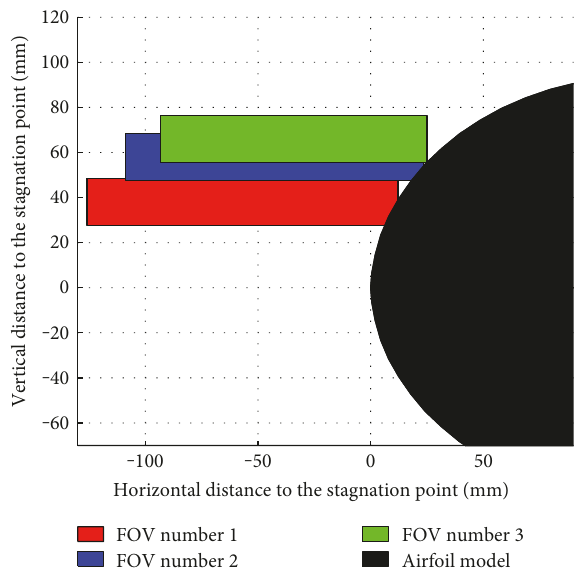
Figure 6: Location of the di ff erent FOV relative to the